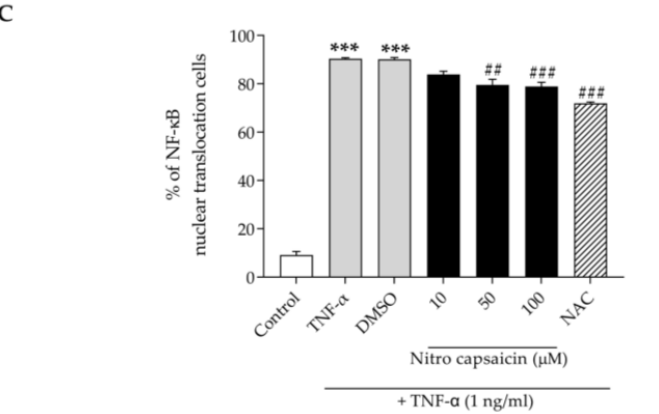
Figure 5. Effect of nitro capsaicin on NF- κ B activation in hCMEC/D3 cells. ( A ) Cell viability following treatment with different concentrations of nitro capsaicin and capsaicin in hCMEC/D3 cells. ( B ) Representative western blot and quantification graph showing p-NF- κ B p-65 Ser536 and NF- κ B p-65 expression levels. ( C ) Graph represents percentage of NF- κ B nuclear translocation induced by TNF- α in the absence or presence of nitro capsaicin. NAC (10 mM) was used as the positive control. * p < 0.05 and *** p < 0.001 versus control group; # p < 0.05, ## p < 0.01, and ### p < 0.001 versus TNF- α -treated group.